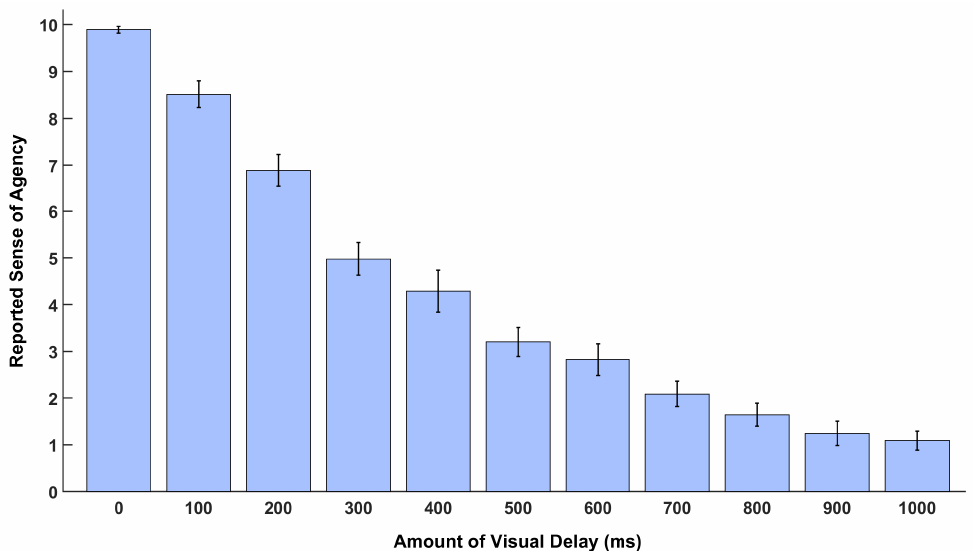
Figure 4. Behavioral results of subjective rating of the Sense of Agency (SoA) with an increasing delay of visual